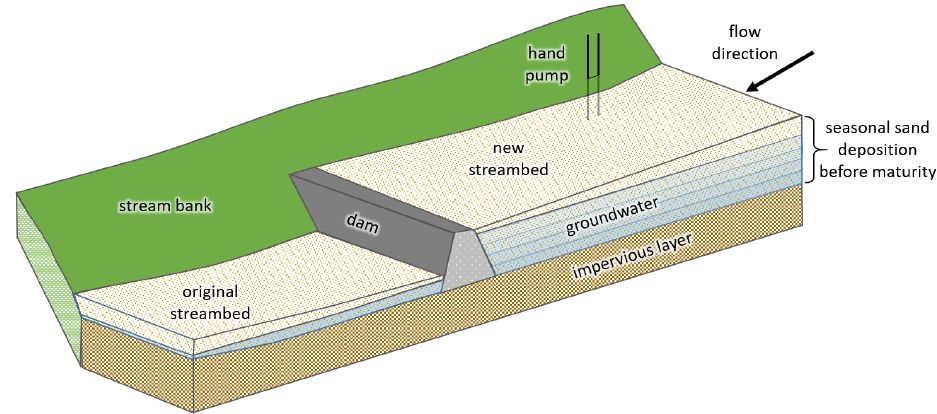
Figure 1. Schematic of a sand dam showing seasonal sand deposition before the dam reaches maturity (adapted from Borst and de Haas,